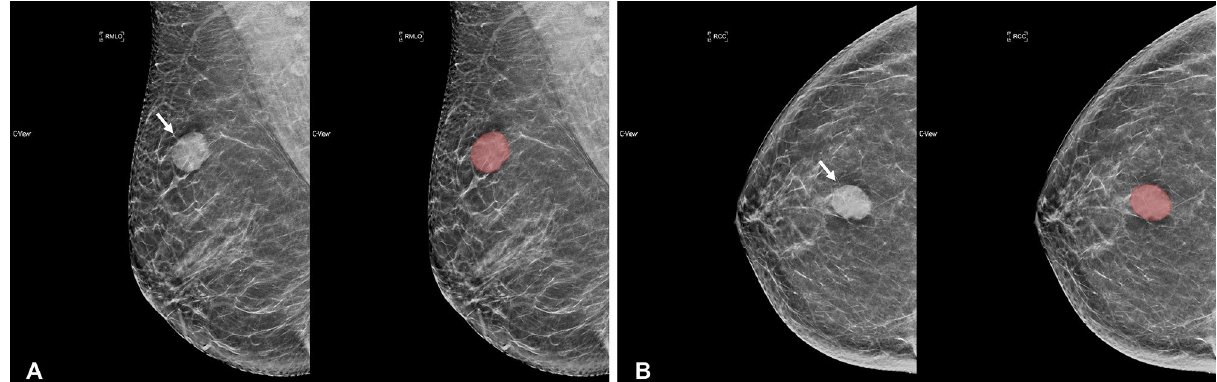
Figure 2. Segmentation example 1. Example of tumor segmentation on synthetic mammography. The synthetic mediolateral oblique (A) and craniocaudal (B) views of a 58-year-old female diagnosed with the triple negative subtype of breast cancer. The breast lesion appears as a circumscribed and round mass with high density